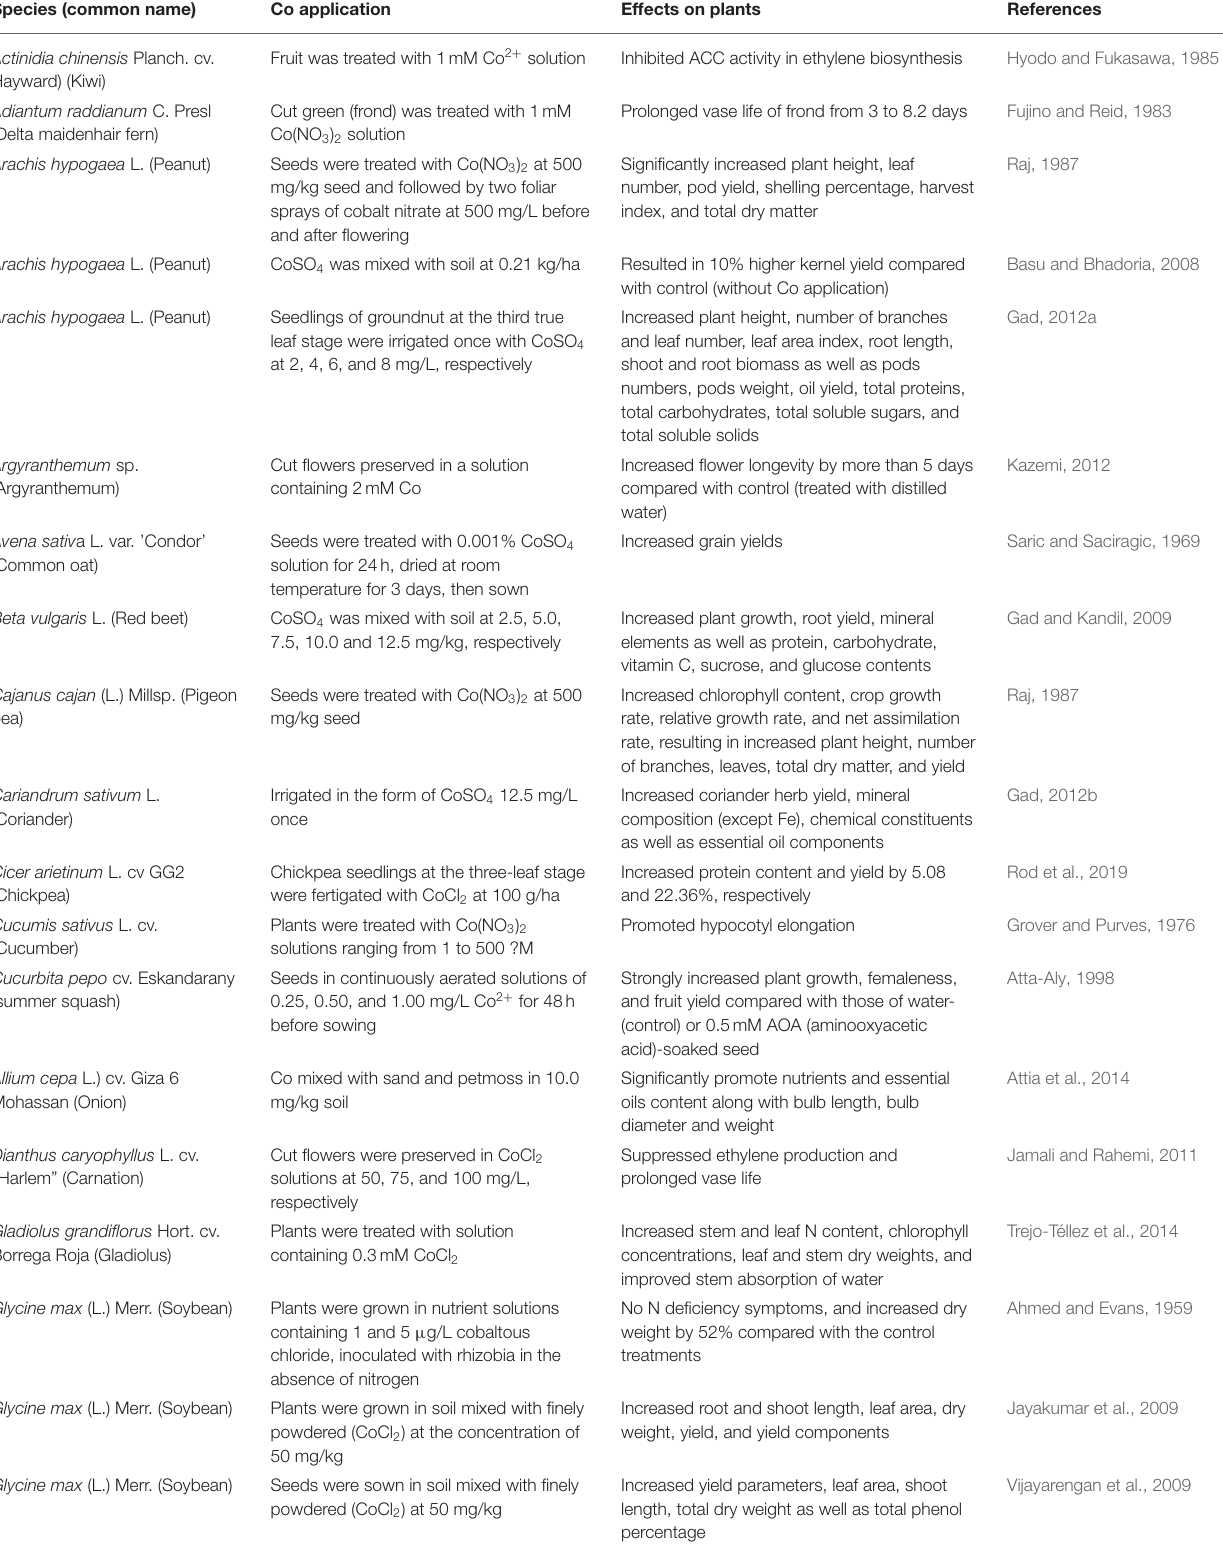
TABLE 4 | Effects of cobalt application on plant